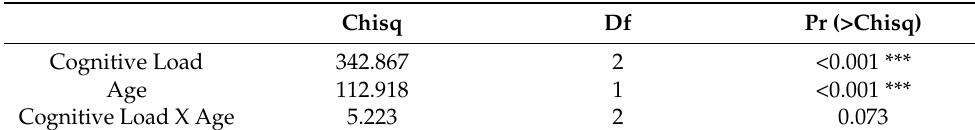
Table 2. Analysis of deviance with the type II Wald chi-square tests for memory score as a function of Cognitive Load and Age. (*** = p -value < 0.001).